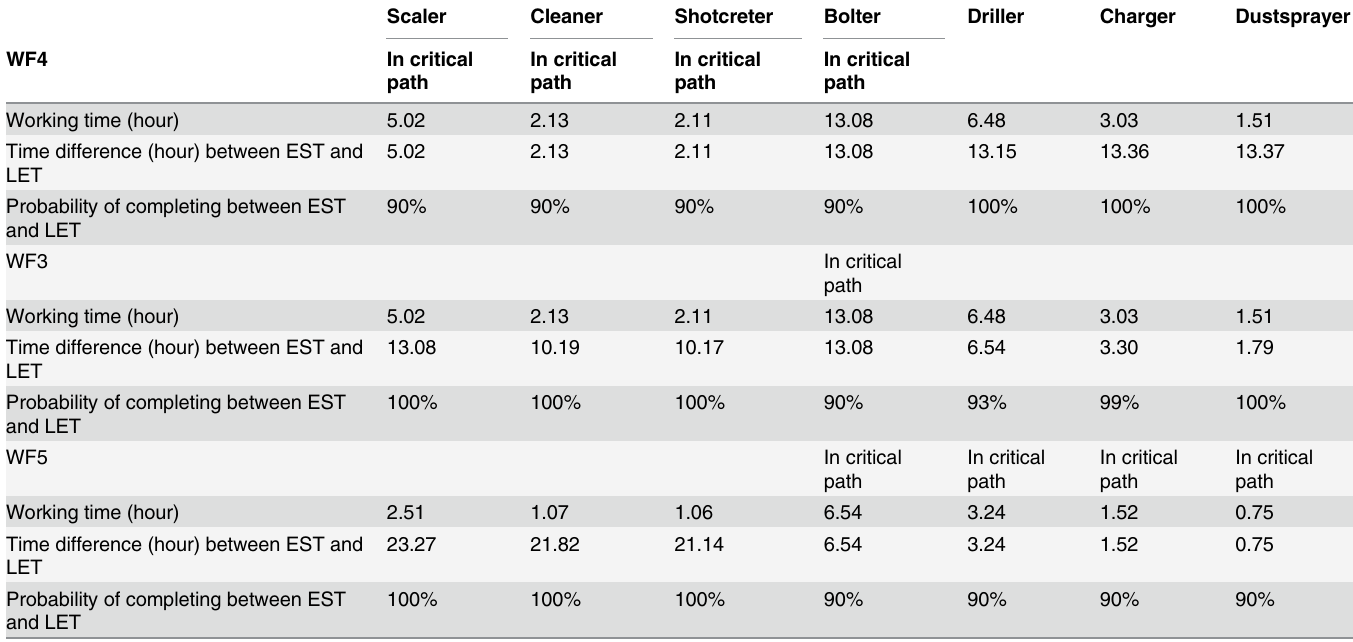
Table 2. Probability and critical path using the new